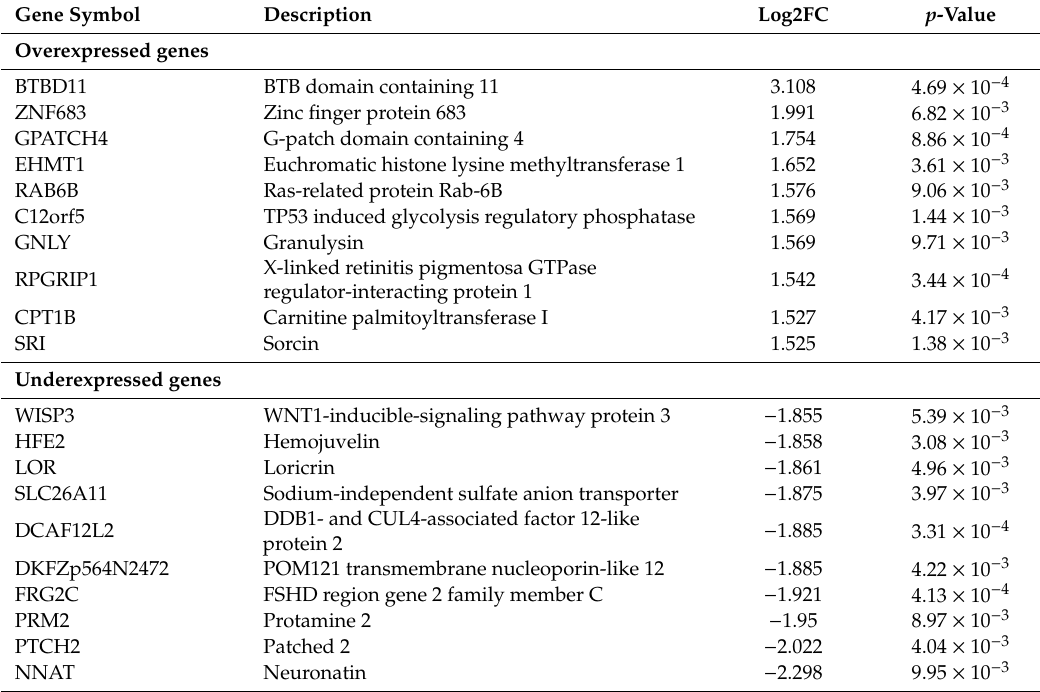
Table 2. Top 10 overexpressed and underexpressed